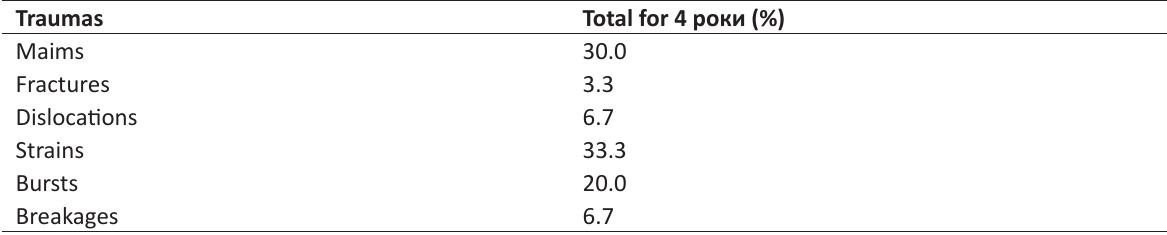
Table 2. Characteristic of traumas by the character of damage (%) Traumas